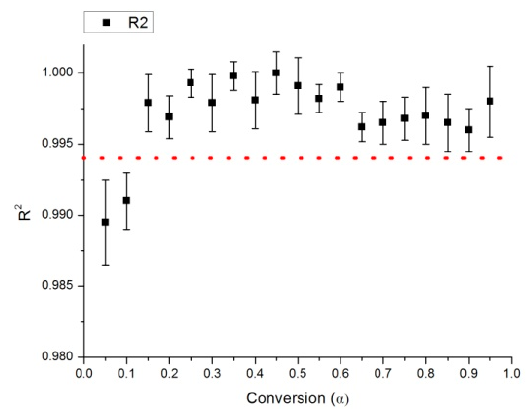
Figure 4. R 2 coe ffi cient for the calculation of activation energy of solid Figure 4. R 2 coefficient for the calculation of activation energy of solid digestate.